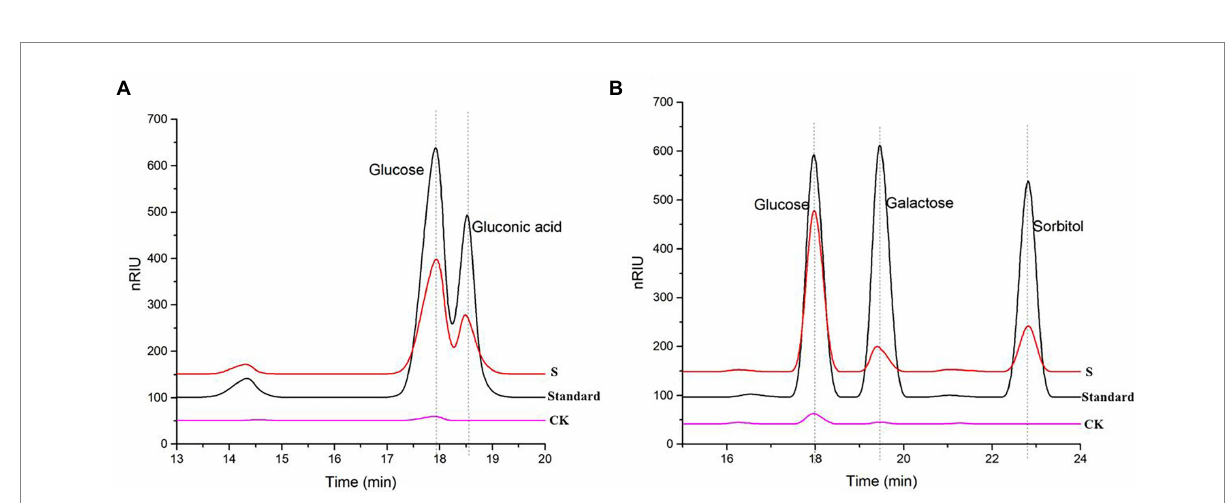
FIGURE 5 Analysis of rTaAA9A reaction products by HPLC-RID. (A) S, rTaAA9A reaction products hydrolyzed by TFA; CK, control sample, analyzed as described above, but without rTaAA9A. (B) S, rTaAA9A reaction products were reduced by NaBH 4 followed by hydrolysis with TFA; CK, control sample was analyzed as above, except that rTaAA9A was not added. Gluconic acid and galactose were used as